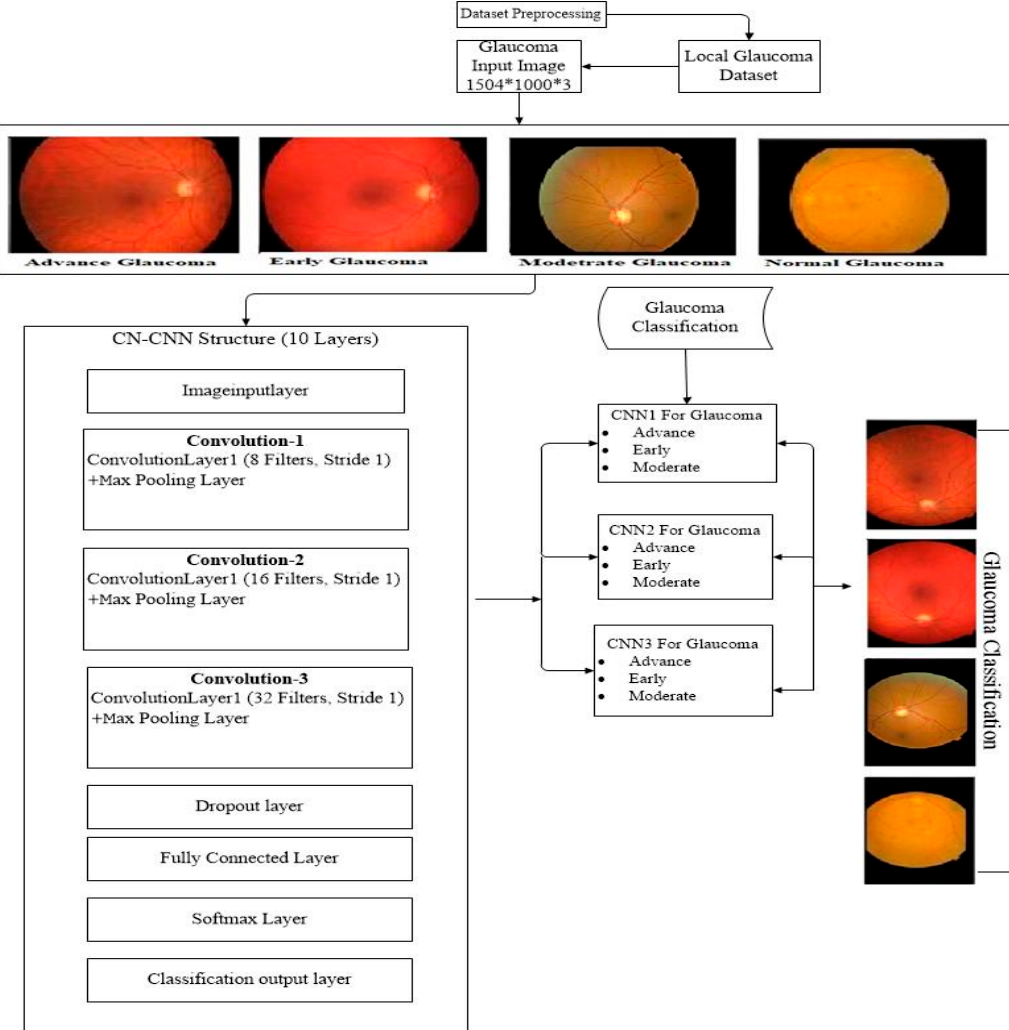
Figure 4. Layer-Wise Representation of the Architecture of Classification-Net-CNN.